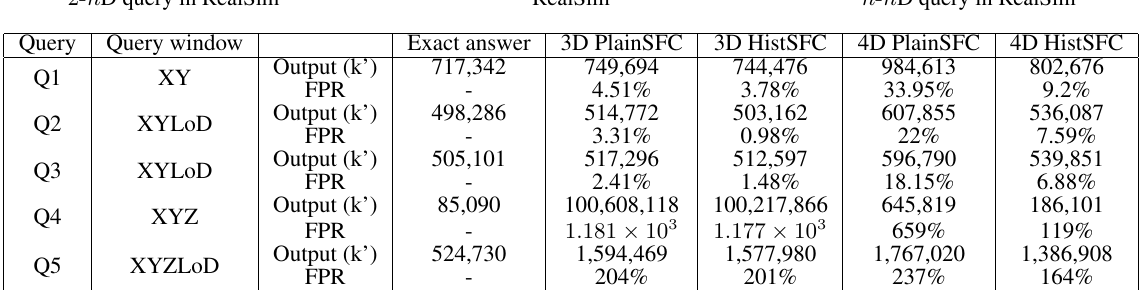
n - n D query in RealSim